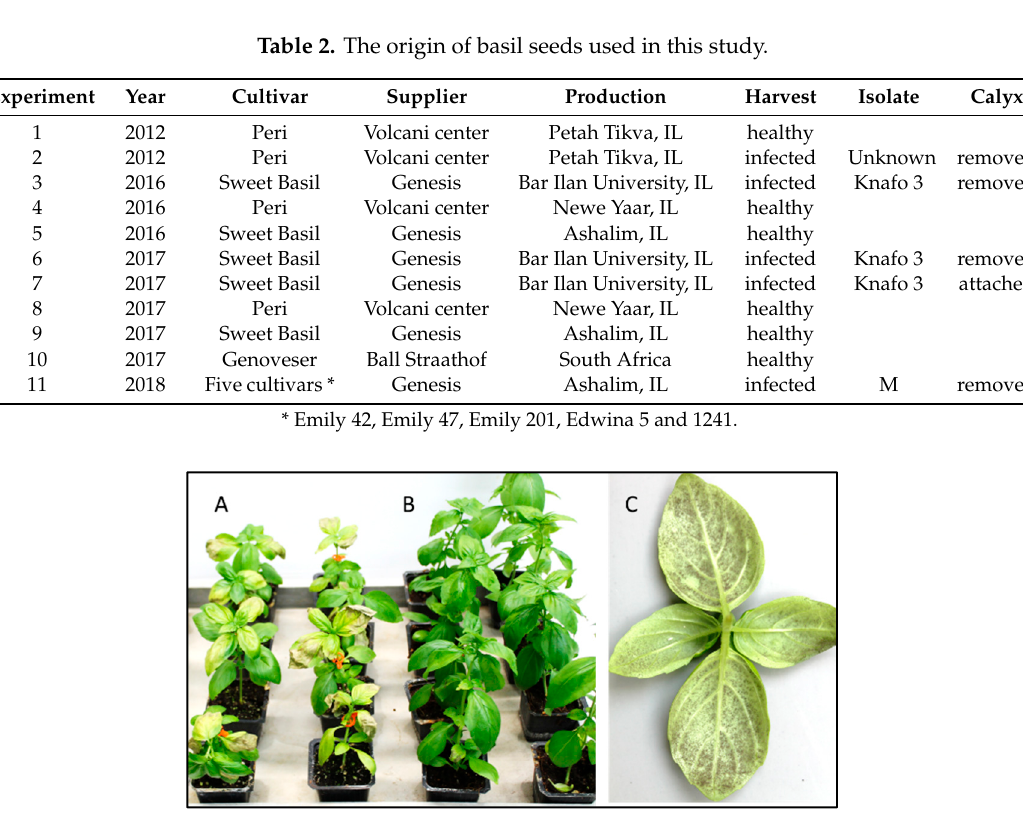
Figure 5. The e ff ect of systemic infection with P. belbahrii on growth of basil plants. ( A )—Systemically infected plants that were inoculated at the 4-leaf stage remained stunted. ( B )—Healthy, water-inoculated control plants. ( C )—Sporulation of P. belbahrii on the lower leaf surfaces of top leaves taken from a systemically infected plant shown in ( A ). The photos were taken at two weeks after inoculation.